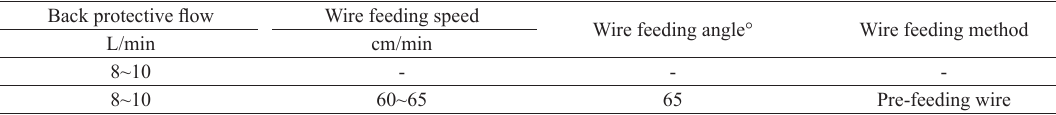
Table 4. Optimum welding parameters of two welding methods for 5.5mm N6 plate-continued Back protective